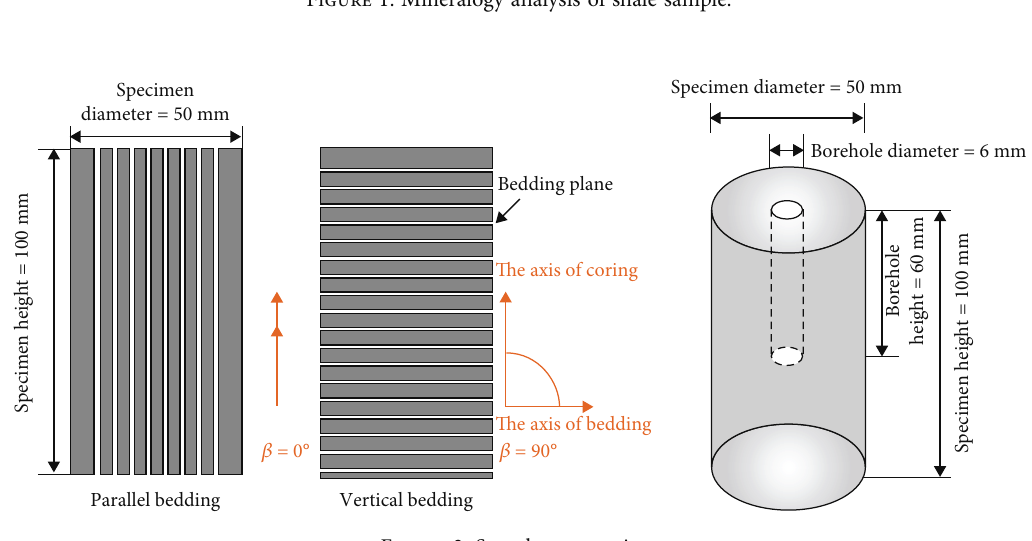
Figure 2: Sample